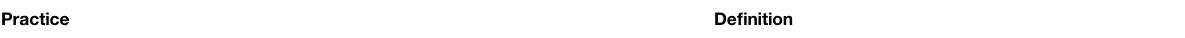
TABLE 1 | De fi nition of OS practices included in the